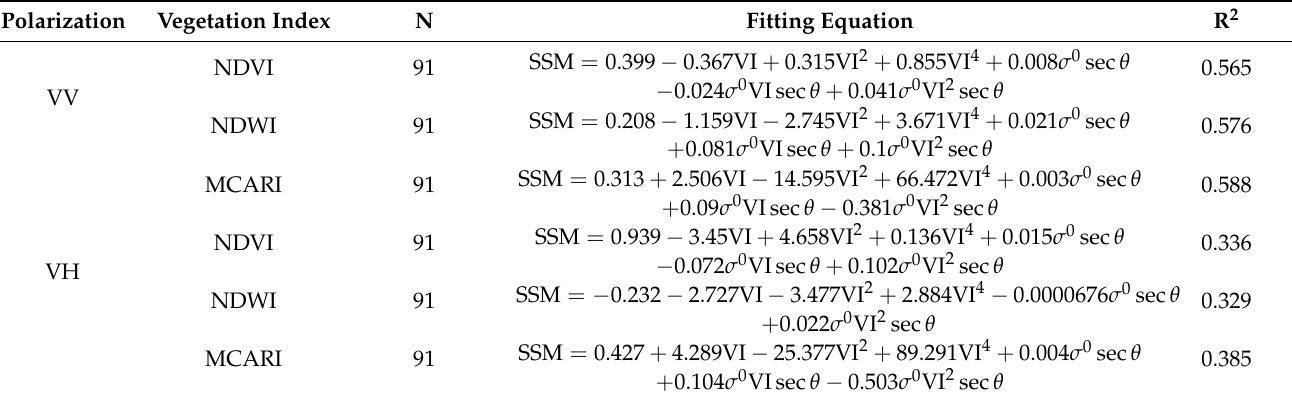
Table 3. Estimation equations and accuracy of SSM under different polarization and vegetation